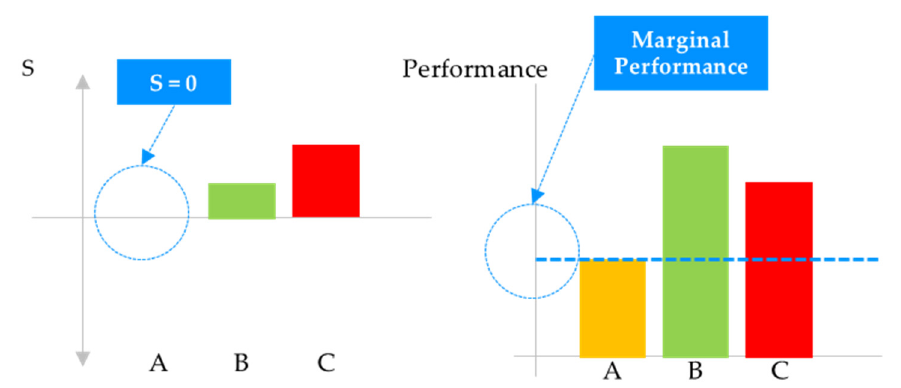
Figure 5. Method for setting up marginal performance target by comparing satisfaction index (SI) to engineering performance.